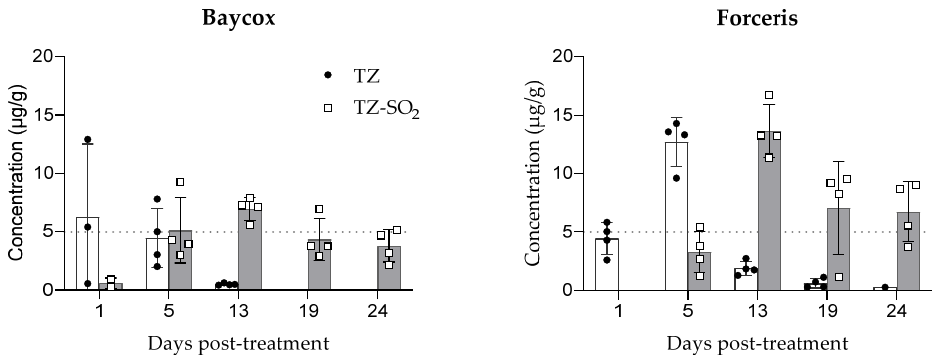
Figure 2. Concentrations of toltrazuril and toltrazuril sulfone (mean ± SD) in jejunal tissue following single oral (Baycox 5%) or intramuscular (Forceris) administration to piglets.